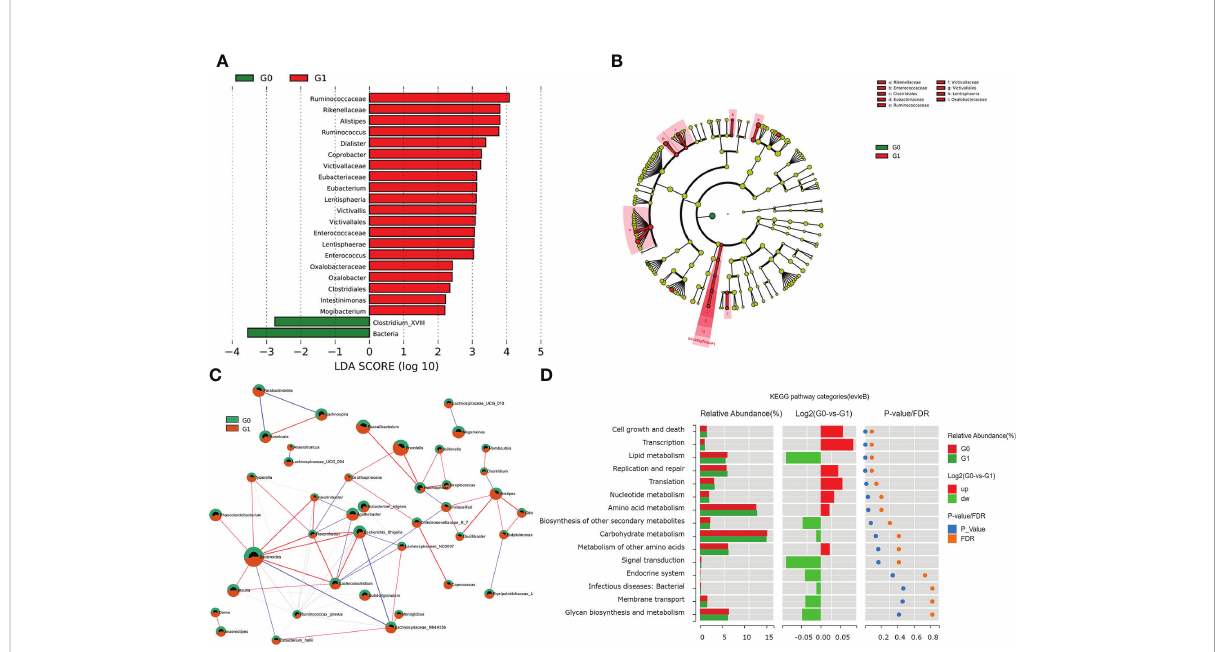
FIGURE 2 Results of gut microbial characteristics and correlations. (A) Histogram of LDA value distribution, list ranked by LDA score. (B) The cladogram shows different taxonomic levels between GADA+ or GADA- group. (C) Correlation among the differentially abundant microbiota in T1D patients. Nodes with correlations between circles represent positive (represented by red lines) and negative correlation (represented by blue lines). (Circle with red part: G1; circle with green part). (D) Wilcoxon test of pathway differences between GADA+ and GADA-groups. The histogram shows the relative abundance for pathway in each group. The middle panel is a histogram of the log2 value of the mean relative abundance ratio in the two groups of the same pathway. The P and FDR values obtained by the Wilcoxon test are shown on the right